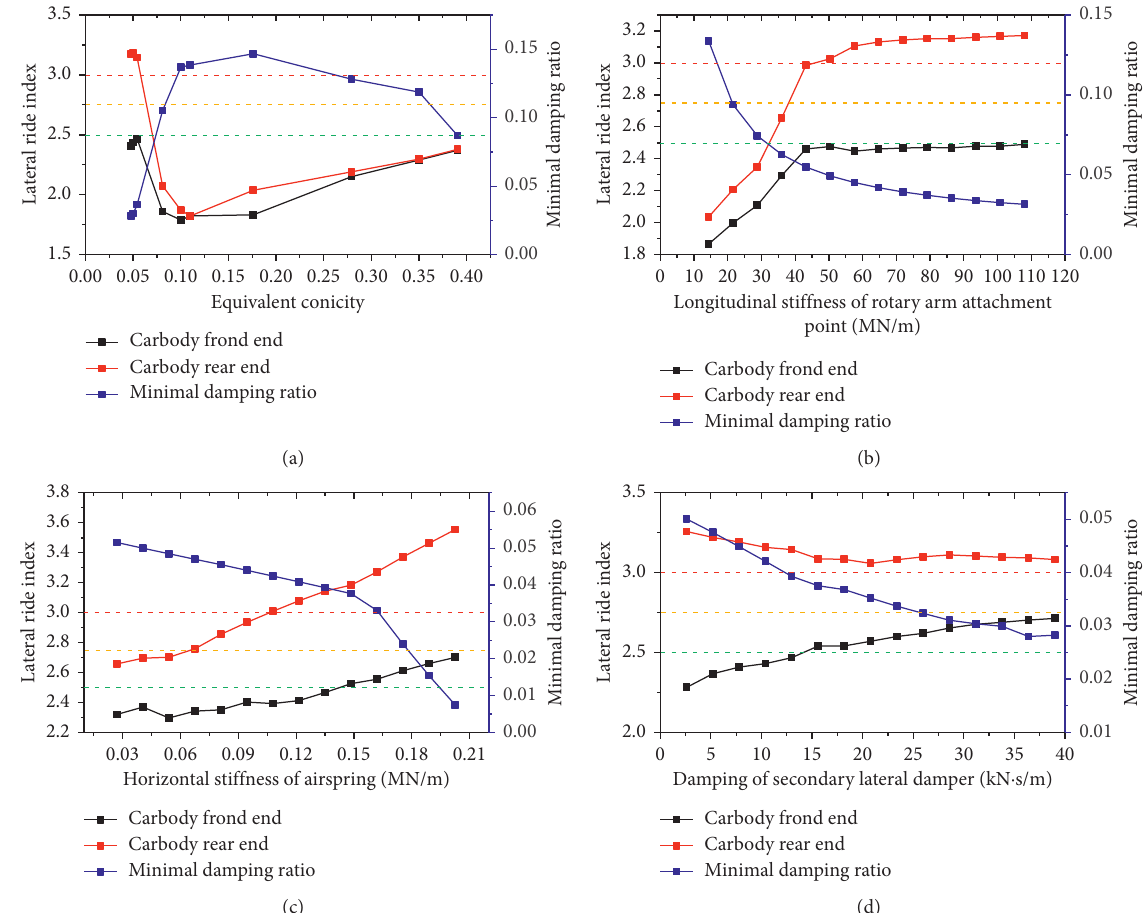
Figure 12: Optimized effect on lateral ride index and minimal damping ratio by (a) equivalent conicity, (b) longitudinal stiffness of rotary arm attachment point, (c) airspring, and (d) damping of secondary lateral